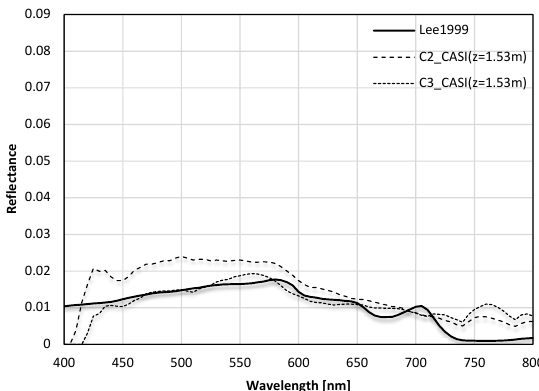
Figure 5 indicates R rs of seagrass target at 2.23 m water depth.